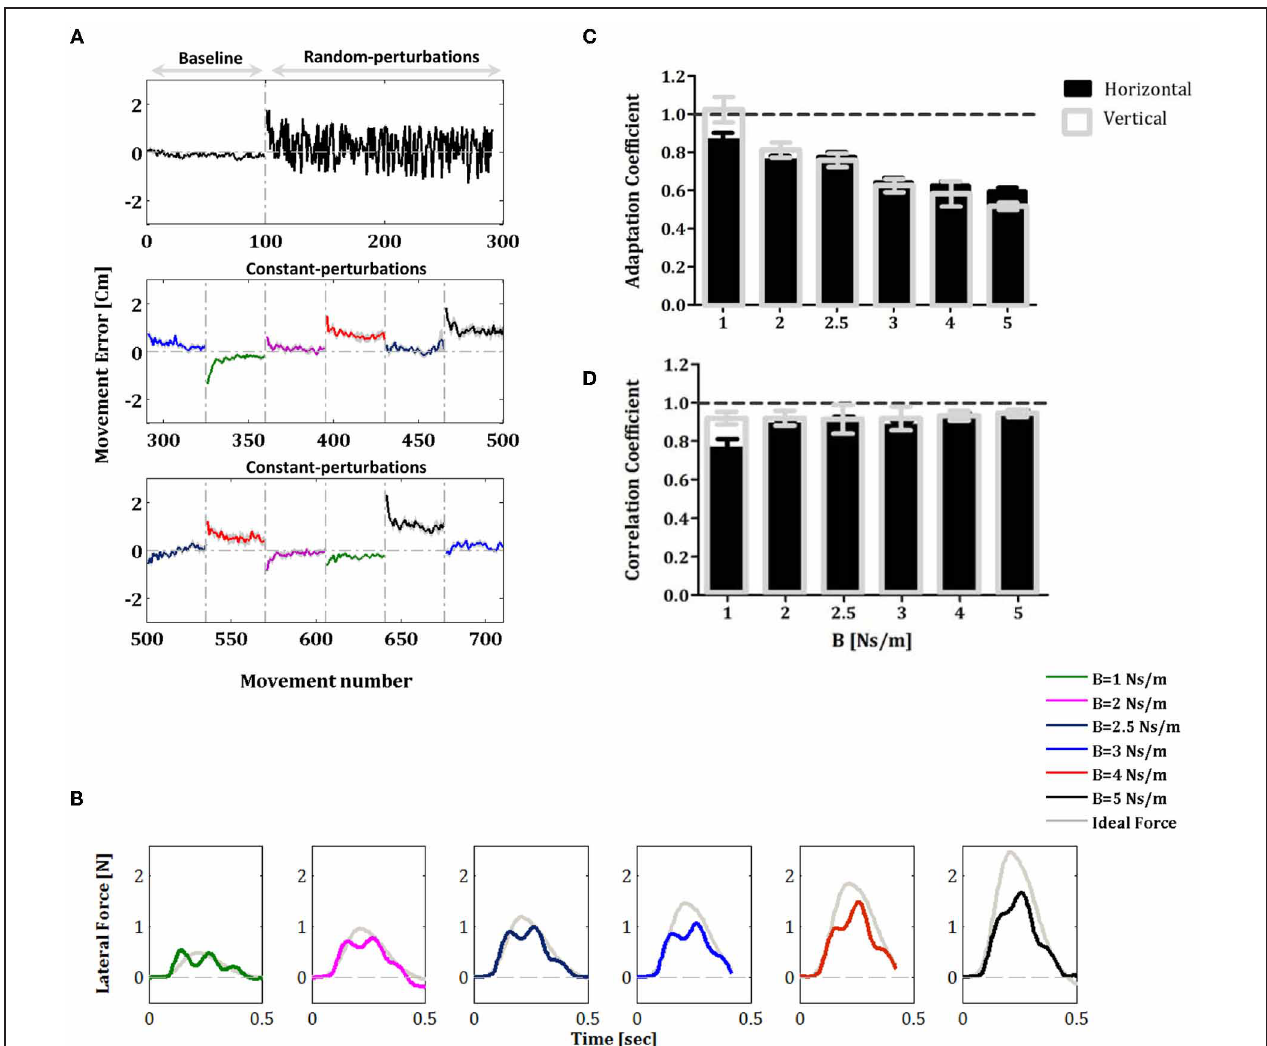
the lateral force profile averaged across all subjects across the ten error-clamp trials for each force-field condition (1, 2, 2.5, 3, 4, and 5Ns/m). The gray trace in eachpanelisthecorrespondingperfectforceprofilethatisbasedontheaverage movement velocity profile that allows full compensation of the force-field perturbation. (C) Comparison of the adaptation coefficients for the different force-field conditions during the constant-perturbations phase; black filled bars for the horizontal experiment and gray unfilled bars for the vertical experiment. (D) Correlation coefficients forthe data presented inB.Error barsrepresent